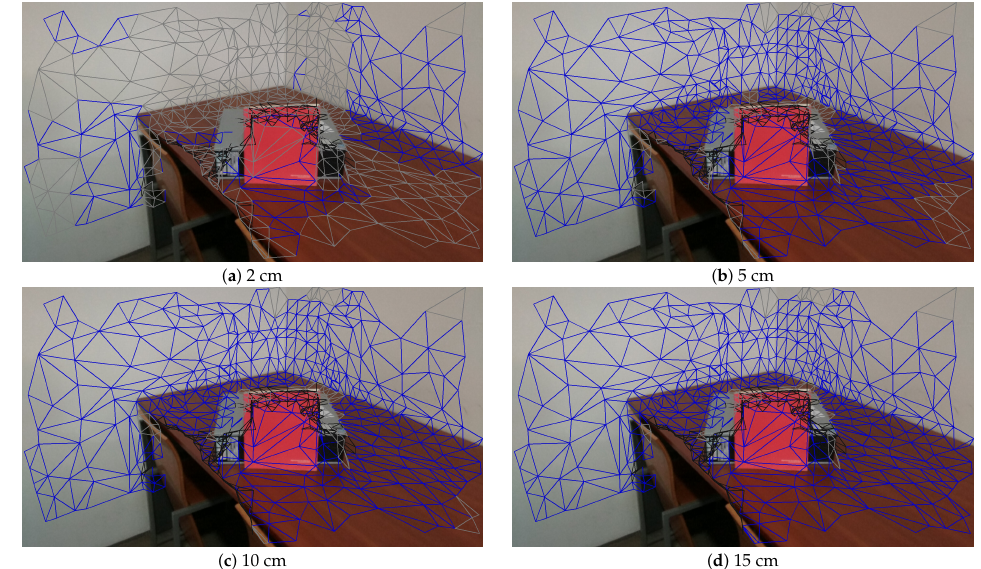
Figure 6. Sensitivity of depth consistency with different thresholds. Figure 7 shows a textured mesh produced using the depth consistency mechanism. Without this mechanism, a misaligned camera projects red color into the wall (see Figure 2b). With our approach, since the misalignment causes a depth inconsistency, the misaligned image is not selected for texture mapping which avoids the